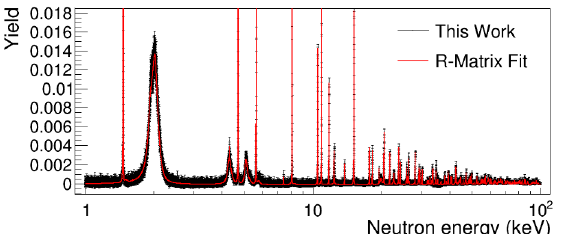
Figure 2. Measured 80 Se(n, γ ) yield between 1 keV and 100 keV (red data-points) and R-matrix analysis fit (red curve).